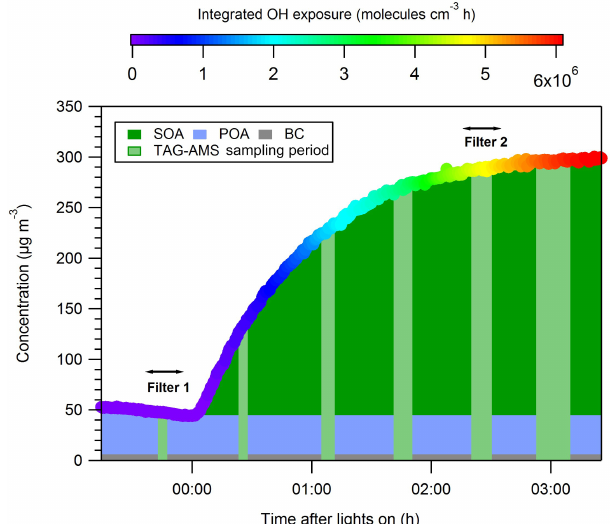
Figure 2. Example of the TAG-AMS and offline (quartz fiber fil- ters) measurements sampling schedule during an aging experiment conducted at the PSI atmospheric chamber with emissions gener- ated from woodstove appliances (Exp. 7, stove B). One sampling with the TAG-AMS is carried out before lights on to characterize POA. At t = 0h, HONO is injected and the lights turned on to initi- ate photo-chemistry. The four to six samples were taken during the aging